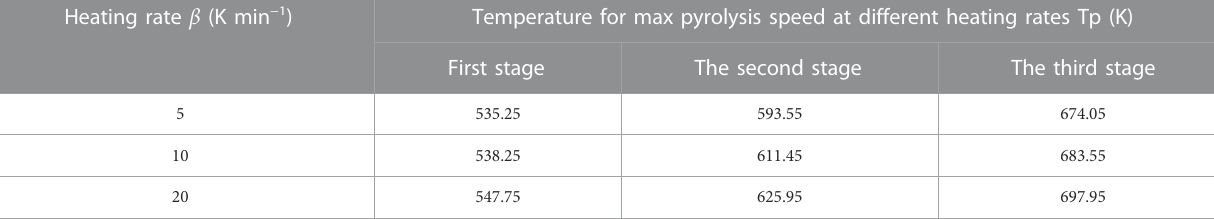
TABLE 2 Data from the TG-DTG curve for the two-step thermal decomposition of galanthamine hydrobromide. Heating rate β (K min − 1 )